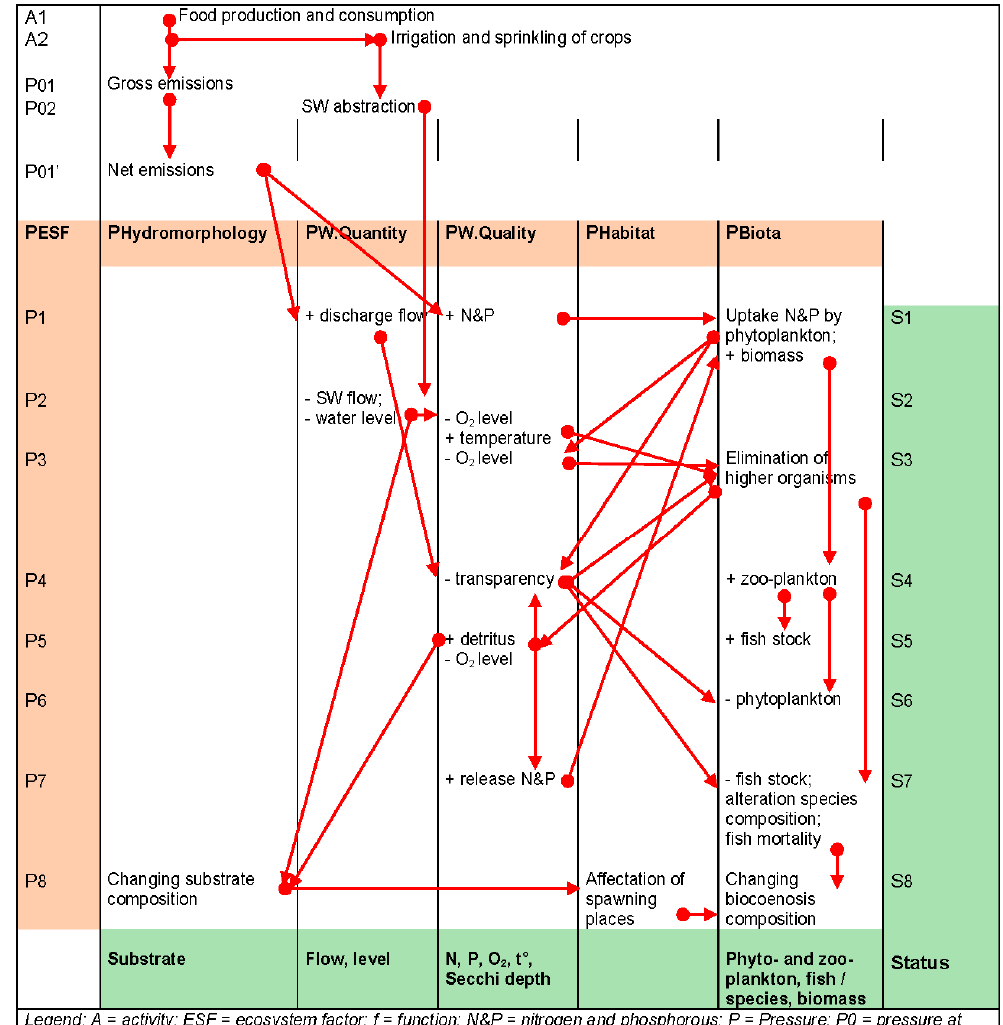
Figure 2. Simplified eutrophication scheme. Arrows show sequences of impacts within and between aquatic ecosystem factors (ESFs). The figure is based on the idea that the final status is the result of a chain reaction of activities (A), partial pressures (P) and related statuses (S).